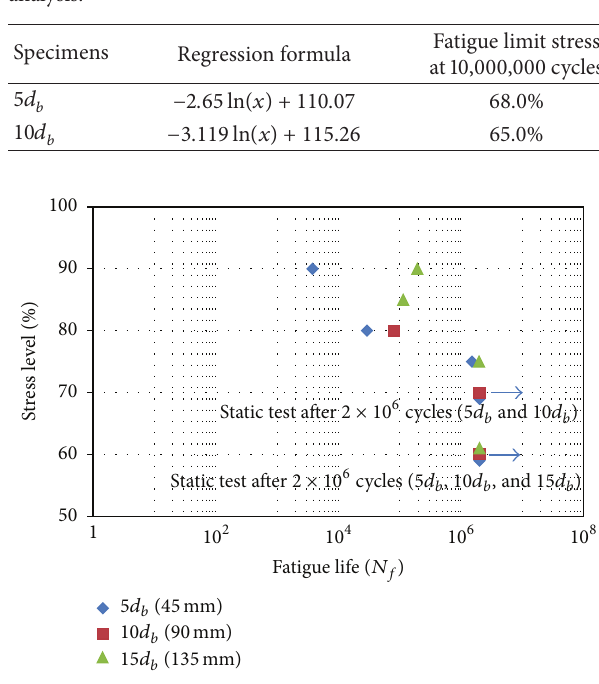
Figure 11: S-N relationship of the flexural bond test specimens.